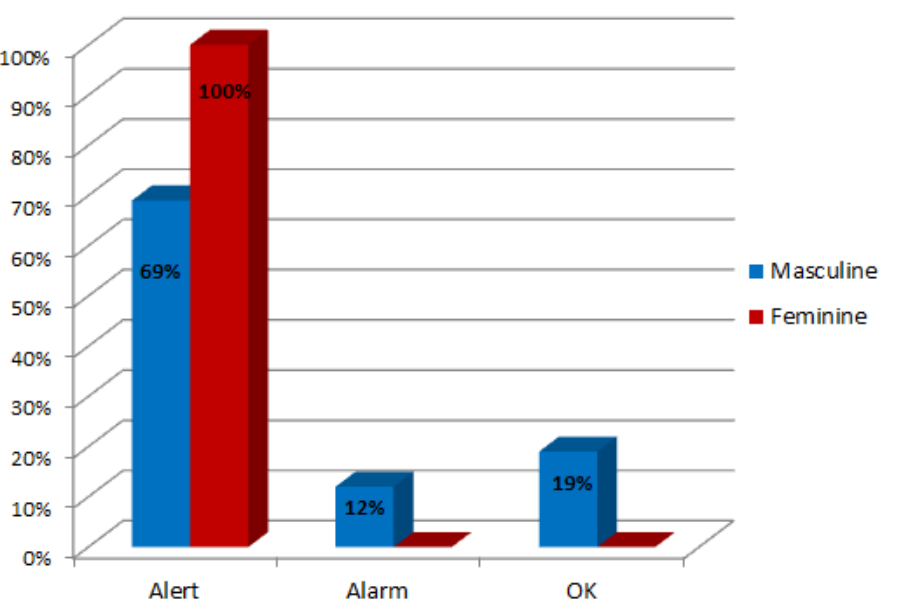
Figure 14. Results of language evaluation by gender.